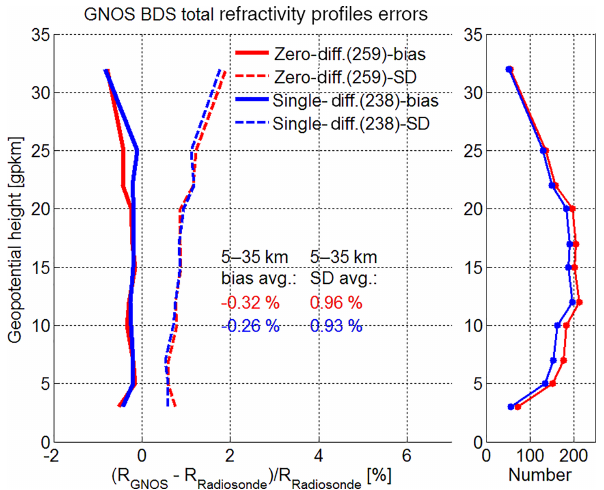
Figure 9. Mean difference (bias) and standard deviation (SD) statis- tics of the GNOS refractivity profiles retrieved by using either zero differencing (red) or single differencing (blue), with collocated ra- diosonde refractivity profiles used as reference ( ± 1 lat–long / ± 1h collocation criterion). Bias (solid) and SD (dashed) profiles as well as the number-of-event profiles (small panel on the right) are shown for the total set of BDS RO events. The legends also indicate the number of events involved and the average bias and SD values within